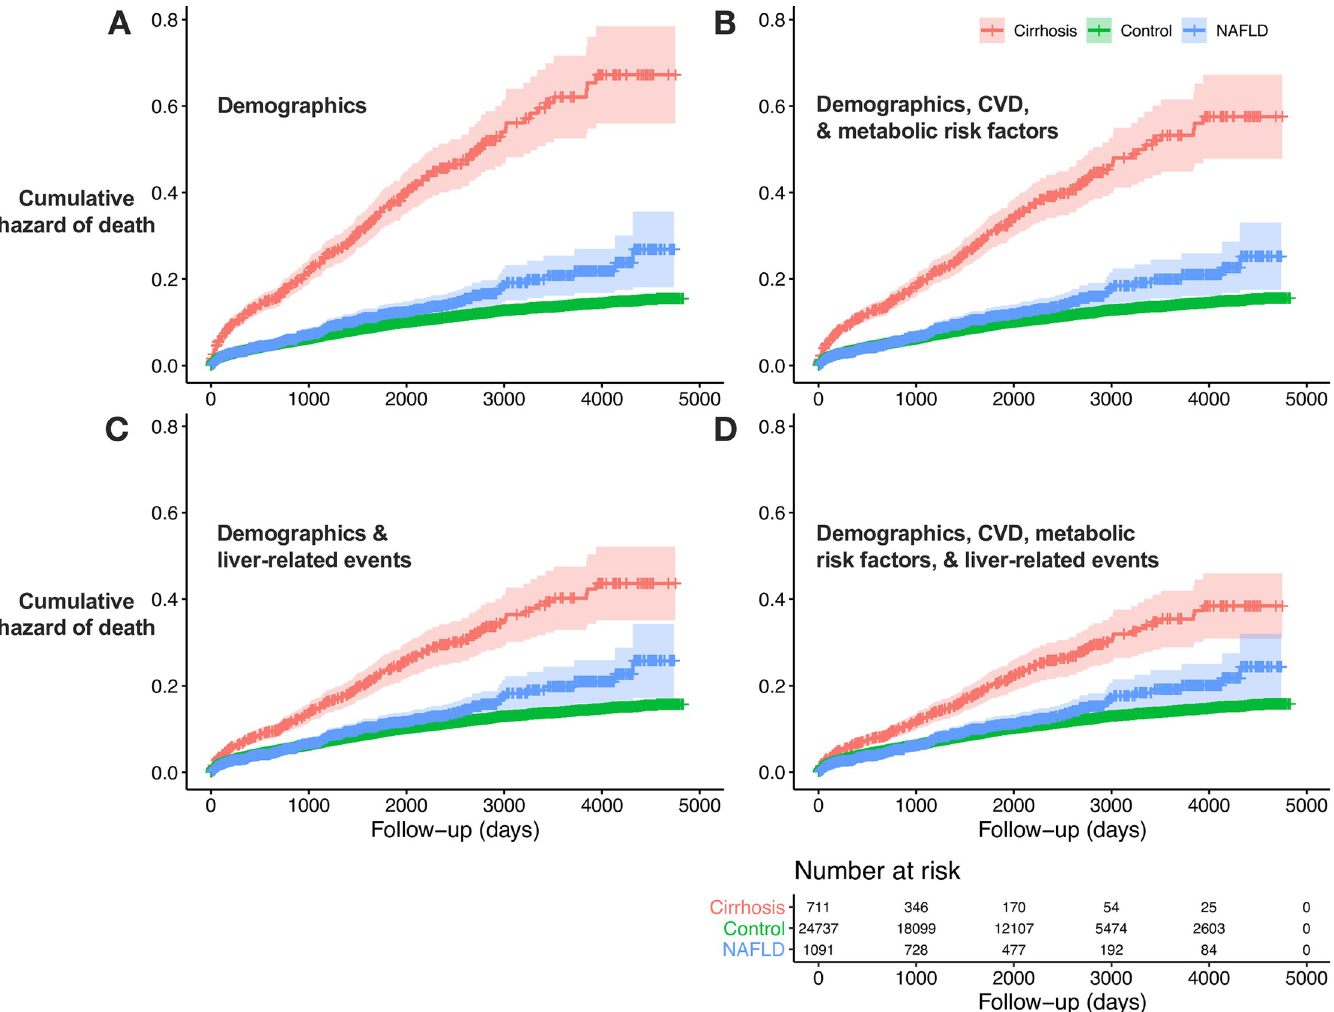
Fig 1. Adjusted cumulative hazard of mortality for hospitalised controls, patients with non-cirrhotic NAFLD, and NAFLD-cirrhosis. Survival curves showing cumulative hazard of mortality derived from four models of adjustment using Cox proportional regression. Data shows 95% CI for control n = 24,737; NAFLD n = 1,091; and Cirrhosis n = 711. (A) Adjustment for demographic characteristics only (gender, age and ethnicity). (B) Adjustment for demographics plus CVD and metabolic risk factors (obesity, type 2 diabetes mellitus, CHF, ischaemic stroke, myocardial infarction, chronic kidney disease, peripheral vascular disease, hypertension, hyperlipidaemia, ischaemic heart disease, and atrial fibrillation). (C) Adjustment for demographics and liver-related events (hepatocellular carcinoma, hepatic failure, oesophageal varices, portal hypertension, splenomegaly, and ascites). (D) Adjustment for demographics, CVD, metabolic risk factors, and liver-related events.